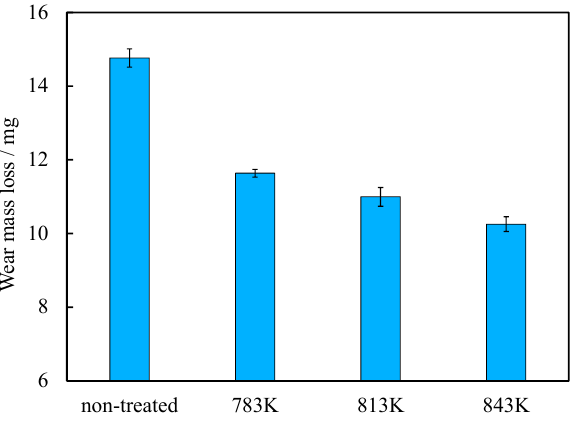
Figure 8. Suga-type abrasive wear test results of ASPN-treated plate samples.